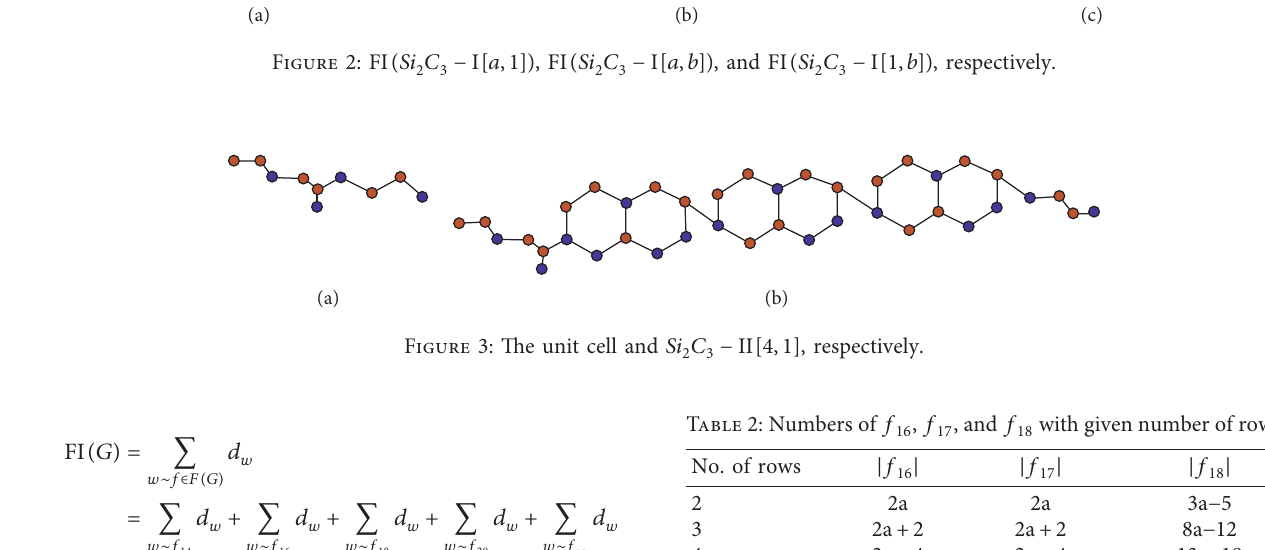
C − I [ a, 1 ]) , FI ( Si 2 3